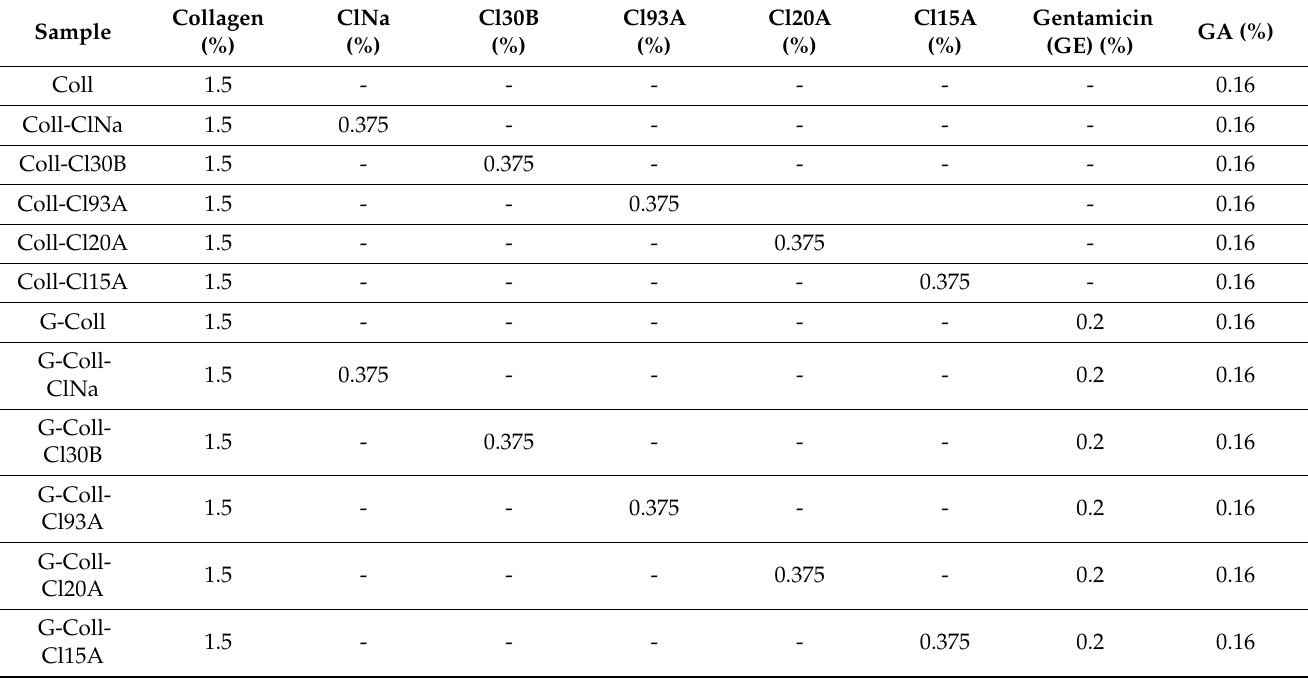
Table 4. The composition of the new collagen/clay composite biomaterials.